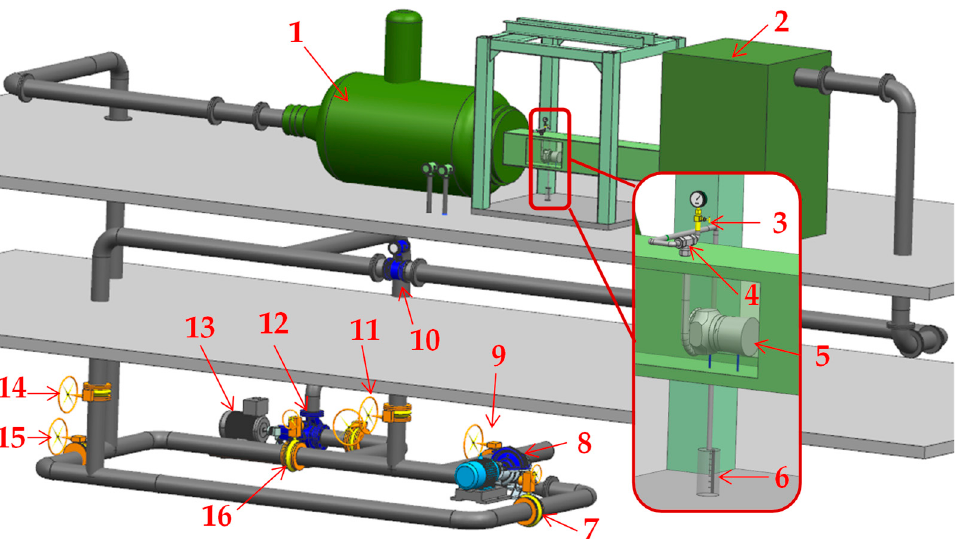
Figure 3. The CAD representation of the test loop: 1—tail water tank, 2—pressure tank, 3—pressure gauge, 4—three-way valve, 5—model hydrokinetic WTP, 6—cylinder, 7—electric valve, 8—variable speed circulating pump, 9—butterfly valve, 10—electromagnetic flow meter, 11—butterfly valve, 12—charging pump, 13—motor, 14—butterfly valve, 15—butterfly valve, and 16—electric valve.